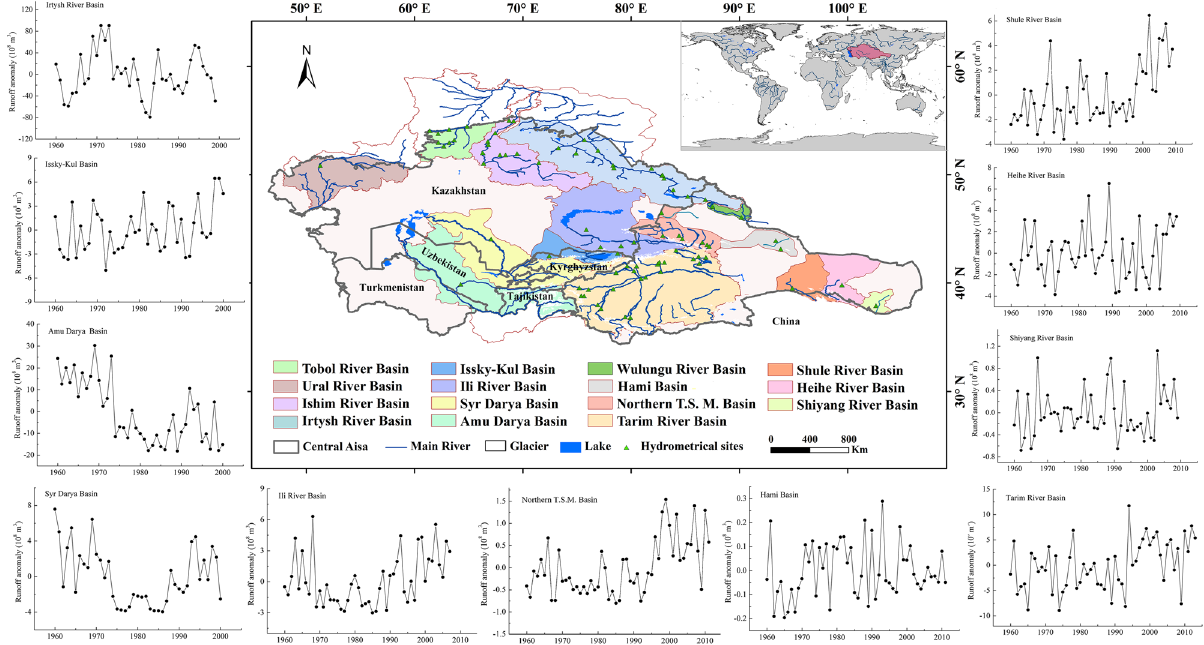
Figure 7. Distribution and runoff changes in the main 11 large rivers in Central Asia in the past half century. (Generated by ArcGIS 10.2, URL: http://www.esri.com/software/arcgis/arcgis-for-desktop, and Matlab 2012a, URL: